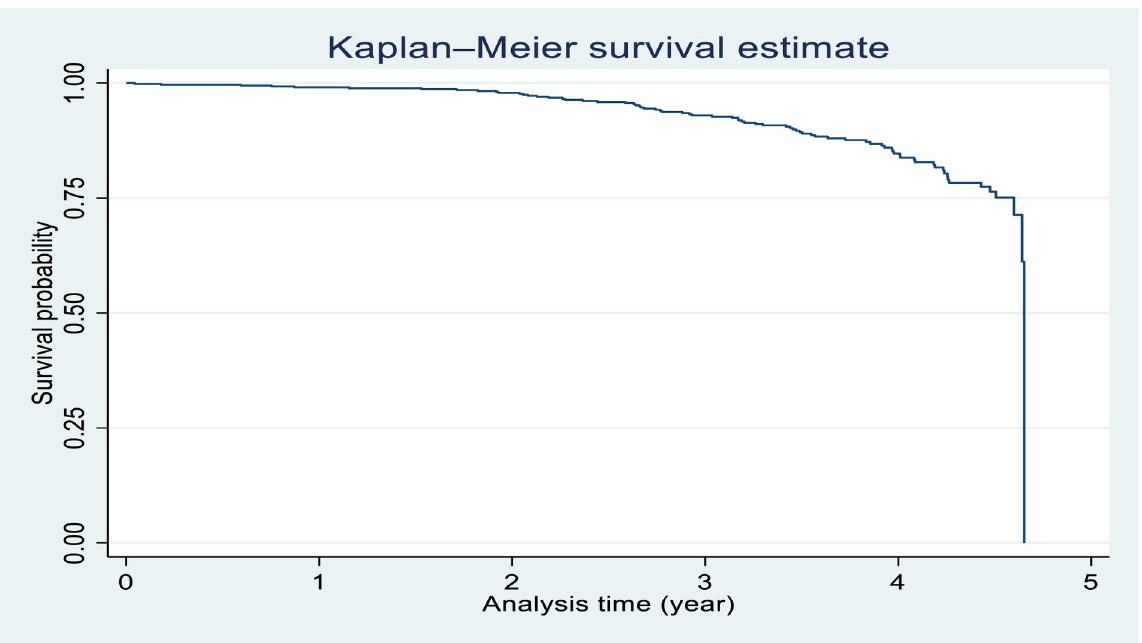
Fig 1. Cumulative survival probability to develop TB with time among patients on ART in St. peter specialized hospital and Zewditu memorial Hospital between January 1, 2016 and August 25,